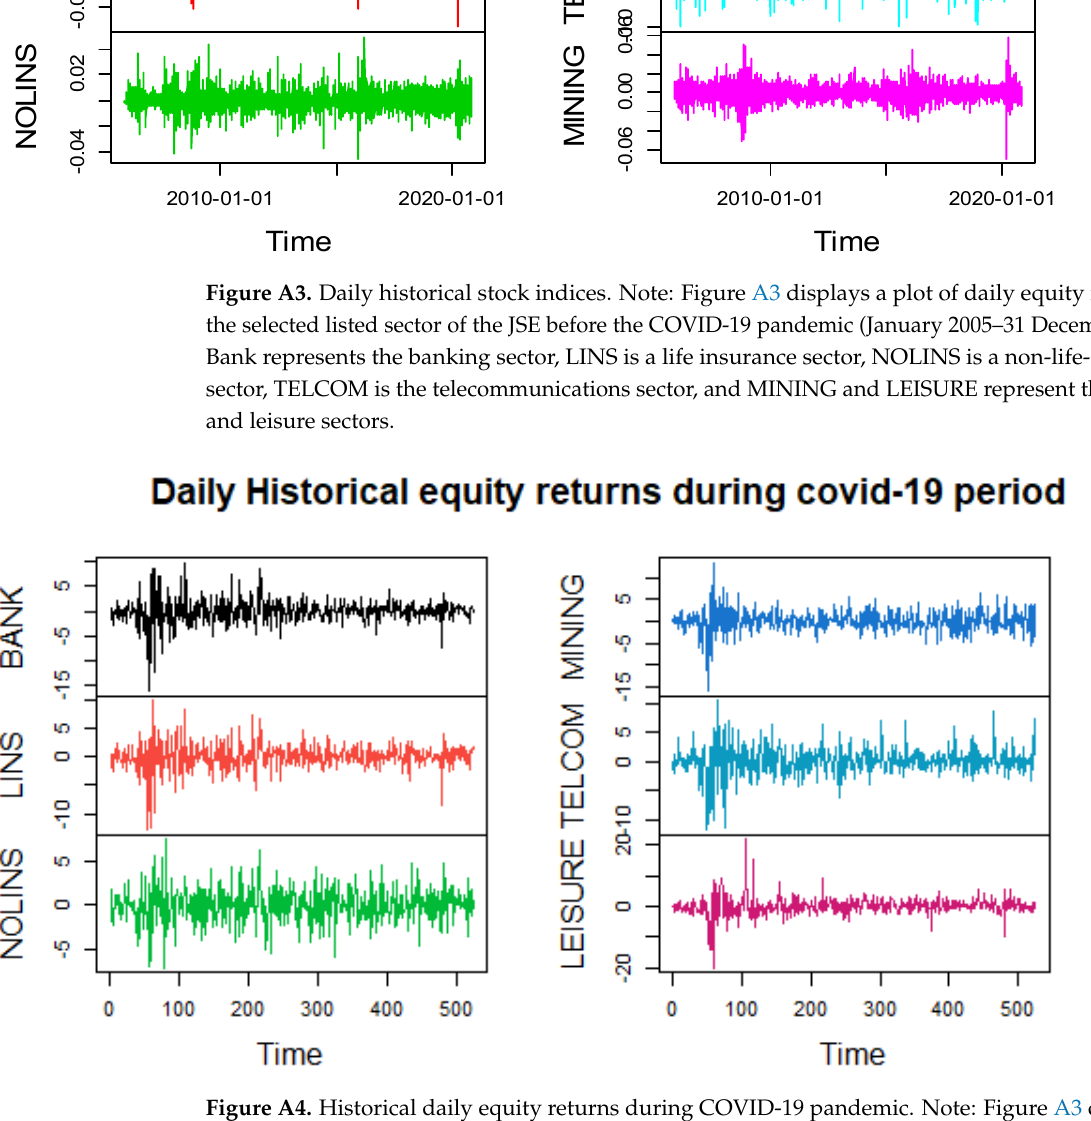
Figure A4. Historical daily equity returns during COVID-19 pandemic. Note: Figure A3 displays a plot of daily equity returns of the selected listed sector of the JSE during the COVID-19 pandemic (January 2005–31 December 2019). Bank represents the banking sector, LINS is a life insurance sector, NOLINS is a non-life-insurance sector, TELCOM is the telecommunications sector, and MINING and LEISURE represent the mining and leisure sectors. We observed that the JSE Top 40 indices crashed after the World Health Organization announced the COVID-19 outbreak as a world health pandemic, and the non-life-insurance and telecommunications sectors remained less volatile.